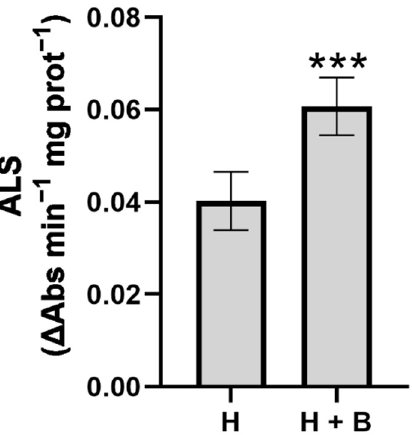
Figure 3. ALS activity in sunflower plants subjected to the treatments (H: Pulsar-40; H + B: Pulsar-40 + Terra Sorb ® foliar). Values are expressed as means ± standard error ( n = 9). The level of significance was represented by p < 0.001 (***).